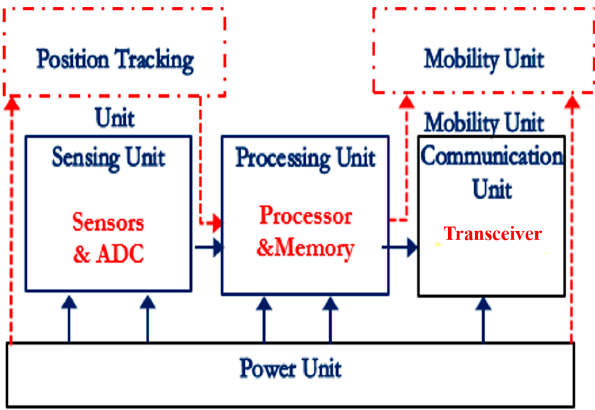
Figure 1. The typical architecture of a sensor node used in Wireless Sensor Networks (WSNs).